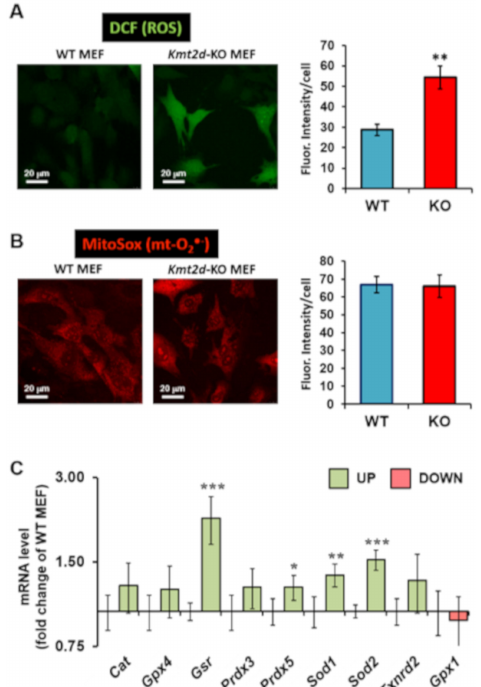
Figure 5. Assessment of the redox homeostasis in Kmt2d -KO and WT MEF. ( A , B ) show the confocal microscopy analysis of cells loaded with the redox-sensitive fluorescent probes DCF and MitoSox, respectively. The panels on the left are representative images, and the histograms on the right are quantification of the fluorescent signal / cell. The bars are means ± SEM of three independent experiments; **, P < 0.005. For each condition, at least 10 di ff erent optical fields were randomly selected containing 10–15 cells each. ( C ) RT-qPCR analysis of gene expression for the indicated proteins involved in the antioxidant defense; the values are fold changes of the transcript in Kmt2d -KO MEF with respect to WT MEF (means ± SD of n = 3; *, P < 0.05; **, P < 0.05; ***, P <